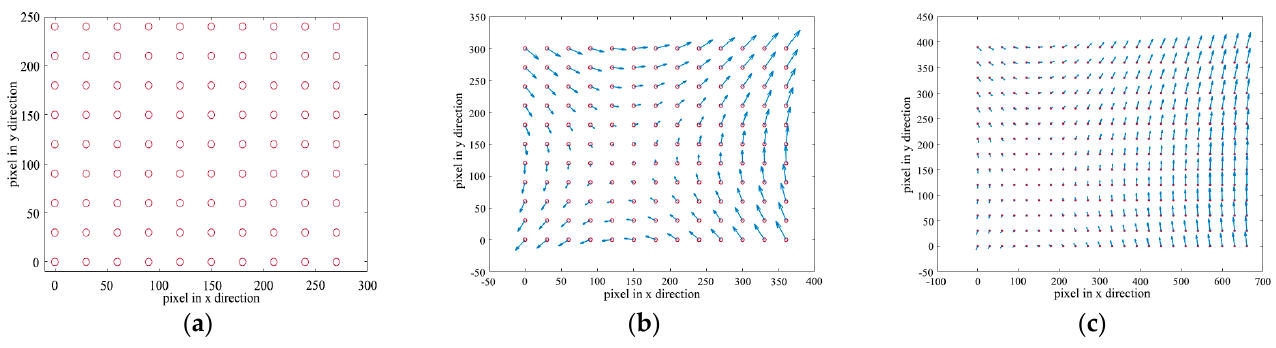
Figure 6. Schematic diagram of distorted image. ( a ) Attitude angle 0°, ( b ) Attitude angle 30°/ − 30°, ( c ) Attitude angle 50°/ − 50°. ( c ) Attitude angle 50 ◦ / − 50 ◦